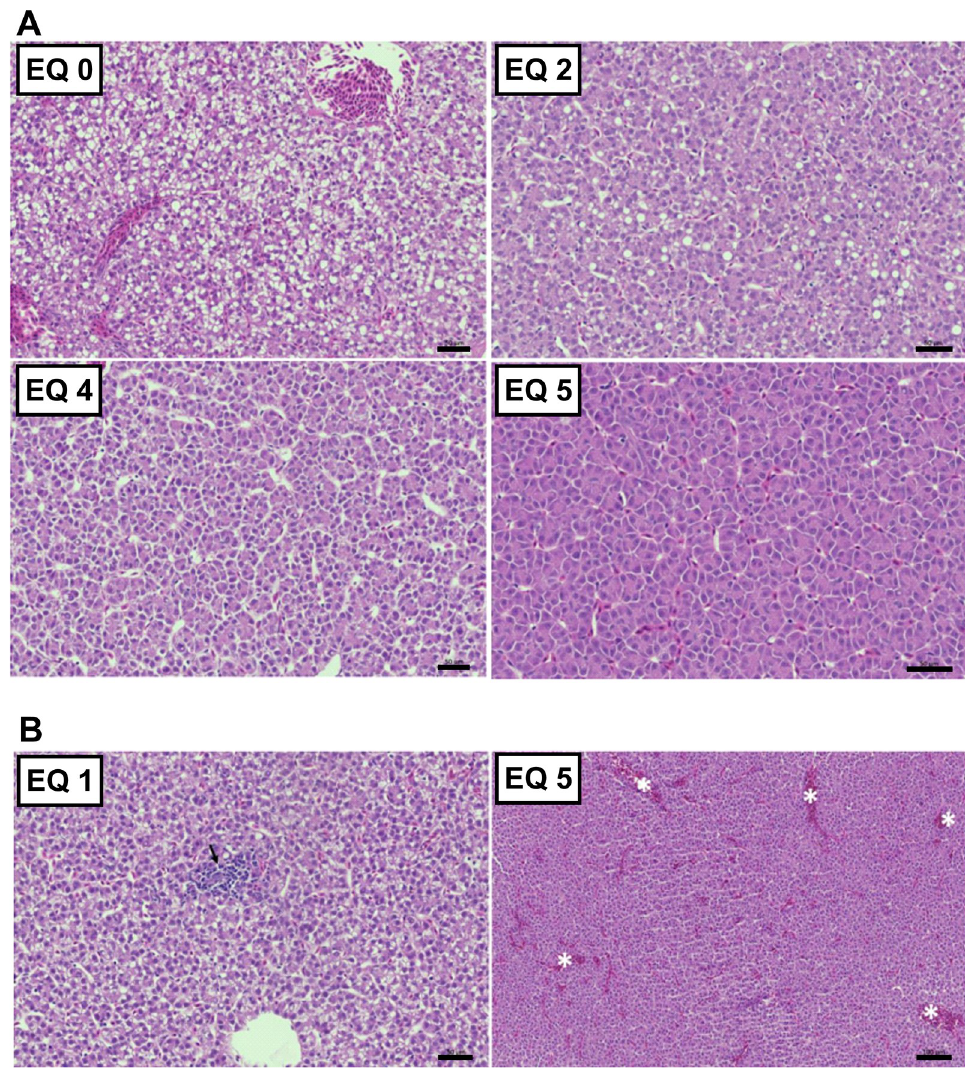
Fig 9. Histopathological findings in of Atlantic salmon ( Salmo salar L.) exposed to graded levels of ethoxyquin (EQ) through their diet for 90 days. Liver sections (5 μ m) showed reduced intracytoplasmic vacuolization along with the increase in dietary content of EQ (A) . H&E, scale bars: 50 μ m. (B) Non-treatment related findings included lymphocytic- type infiltrate (left panel, arrow) and hepatic congestion (right panel, asterisk). H&E, scale bars: 50 μ m (left panel) and 100 μ m (right